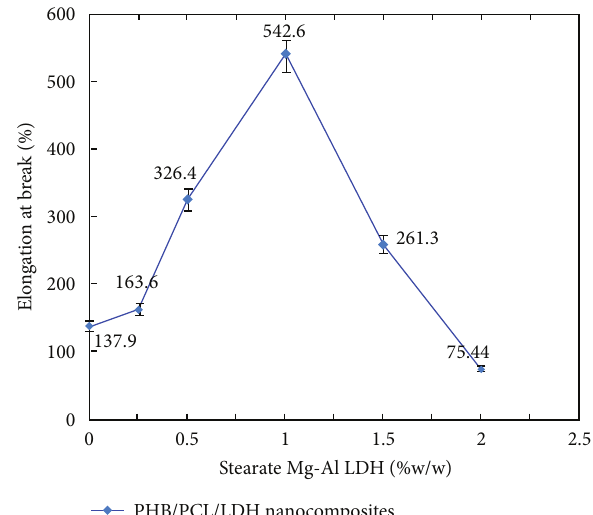
Figure 8: Elongation at break of PHB/PCL/stearate Mg-Al LDH nanocomposites with 0.25, 0.5, 1, 1.5, and 2wt% stearate Mg-Al LDH